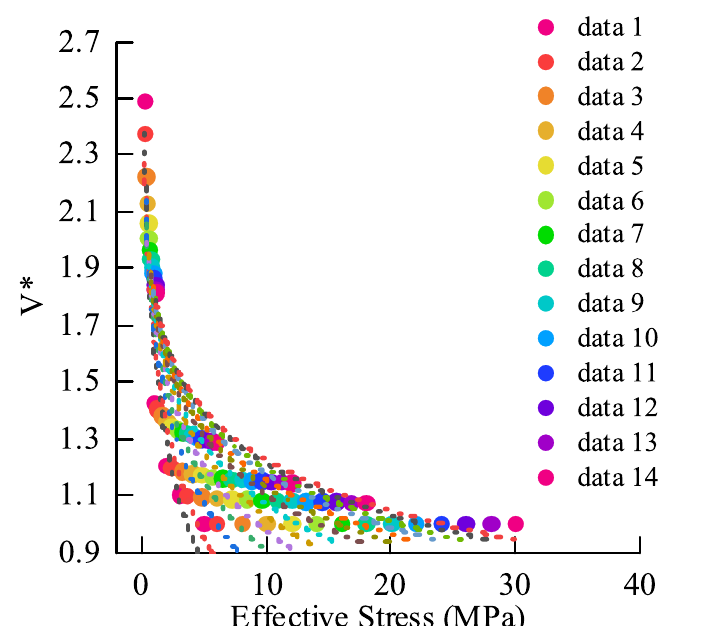
Figure 11. V* and effective stress matrix